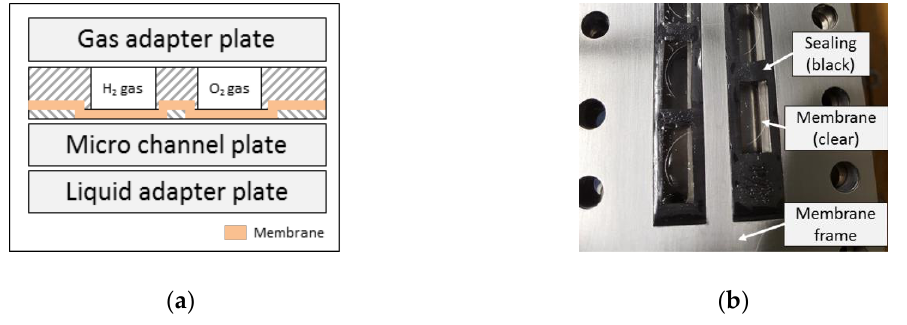
Figure 9. Schematic cross section of the membrane frame ( a ) and photo showing the assembled membrane frame with a 15 μm thick Nafion ® membrane after a test run (an imprint of the meander-like micro channel can be seen on the surface of the clear membrane) ( b ).